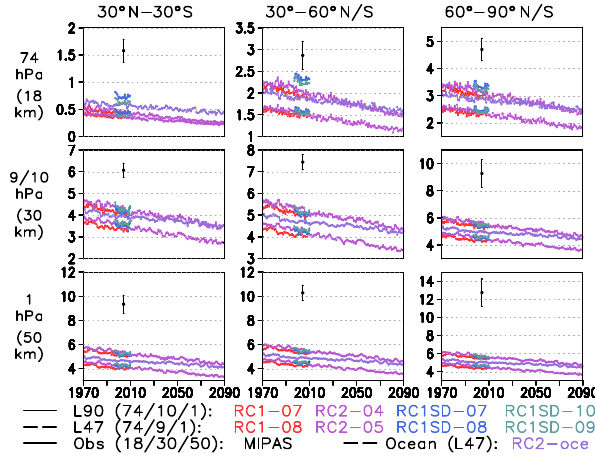
Figure 25. Time series of mean age of stratospheric air (years) at 74hPa / 18km (top), 9hPa / 10hPa / 30km (middle), and 1hPa / 50km (bottom), averaged over the tropics (30 ◦ S–30 ◦ N, left column), mid-latitudes (30–60 ◦ N/S, middle column), and high lat- itudes (60–90 ◦ N/S, right column) in the annual mean. The simula- tion results (colours) are compared to MIPAS data (black), which is averaged for the years 2002 to 2011 with the corresponding stan- dard deviation.